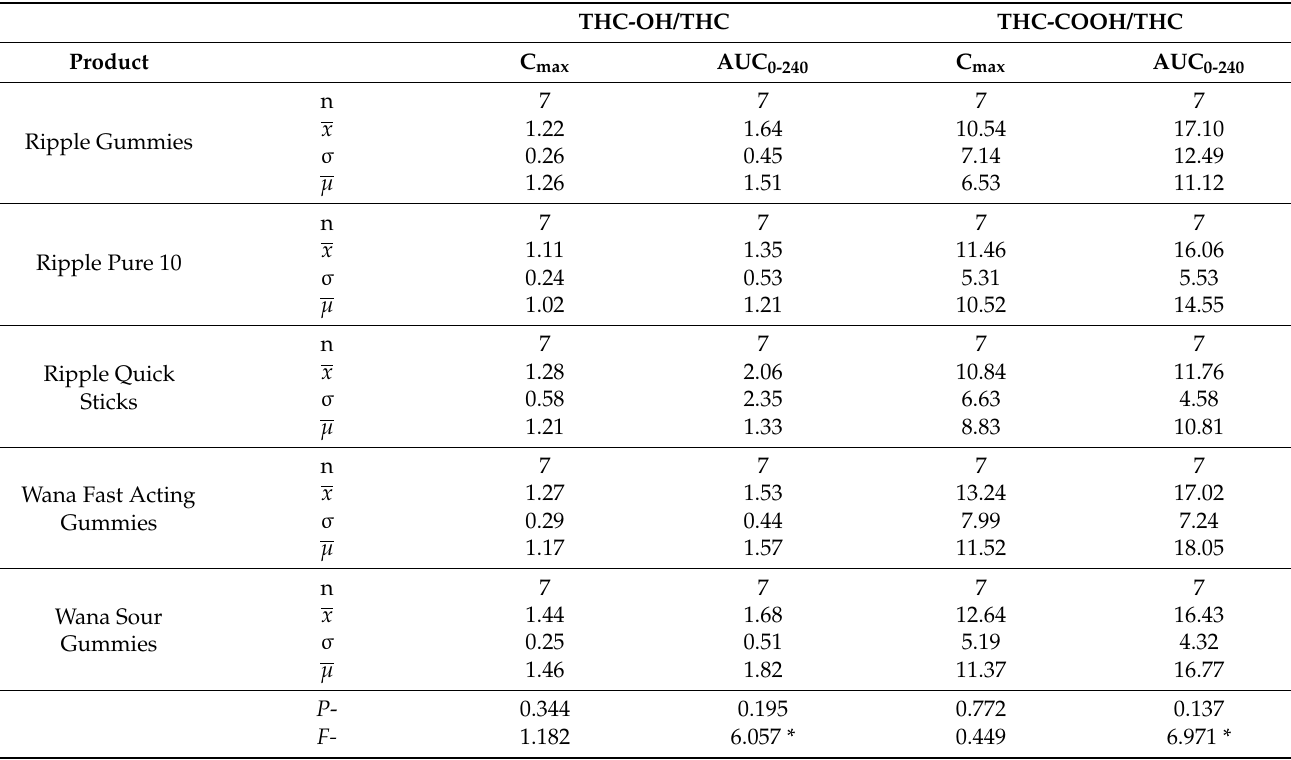
Table 6. Metabolite-to-parent ratios for C max and AUC 0-240